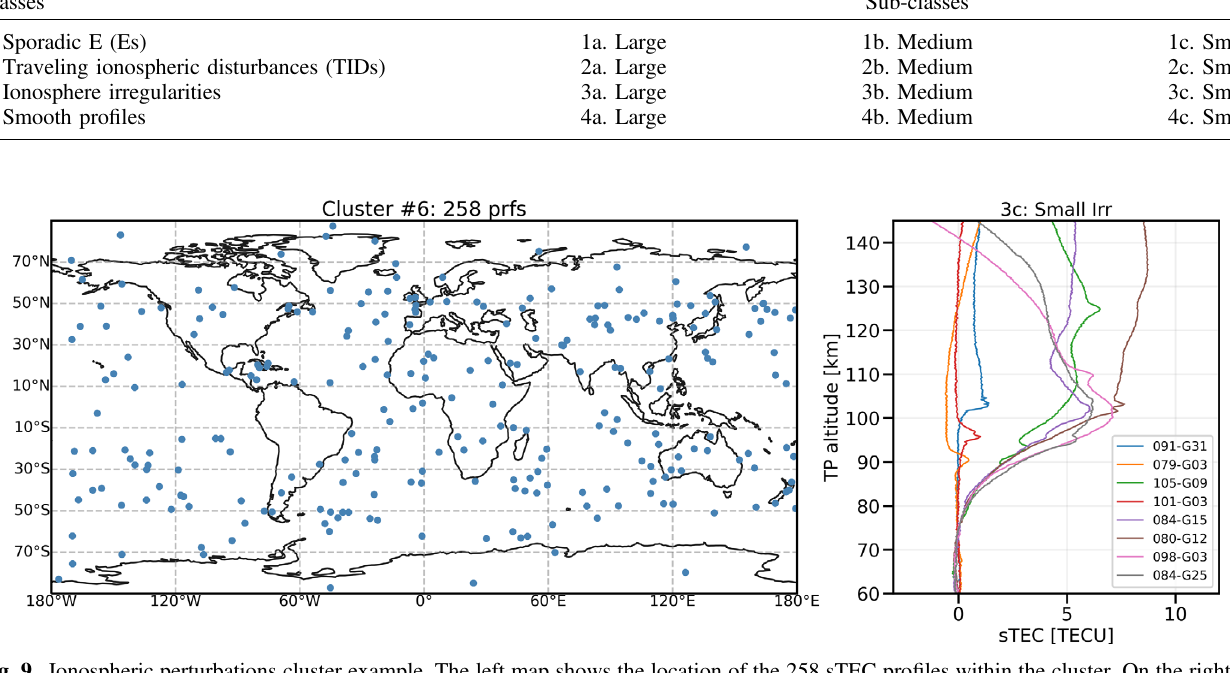
Fig. 9. Ionospheric perturbations cluster example. The left map shows the location of the 258 sTEC pro fi les within the cluster. On the right, 8 randomly selected pro fi les from the cluster. All the pro fi les show similar small-scale sTEC ionospheric perturbations.